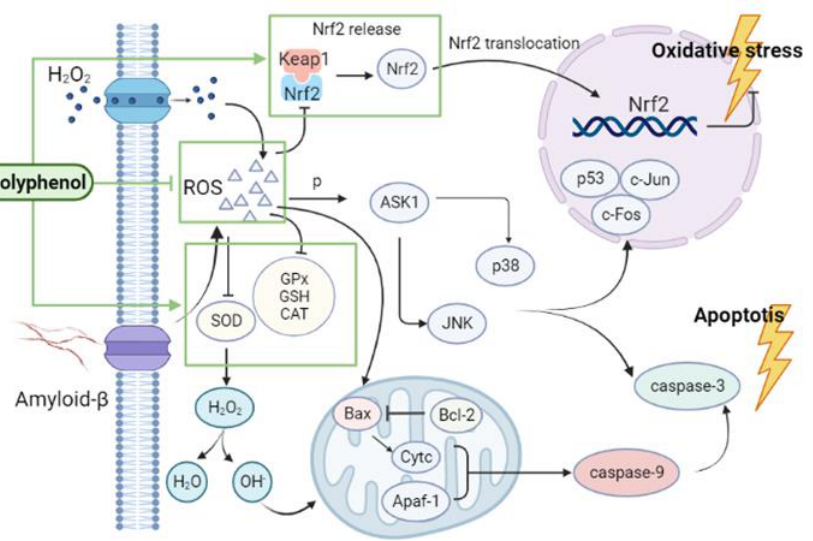
Figure 2. Regulatory roles of polyphenols in the context of oxidative stress: polyphenols can directly clear ROS and inhibit Keap1 to upregulate Nrf2 expression; increase SOD, CAT, and GSH activities; inhibit oxidative stress response; and thus alleviate AD symptoms. Nrf2, nuclear factor erythroid 2-related factor 2; Keap1, Kelch-like ECH-associated protein 1; p53, tumor protein P53; ROS, reactive oxygen species; ASK1, DASH complex subunit ASK1; SOD, superoxide dismutase; GPx, glutathione peroxidase; GSH, L-glutathione; CAT, catalase; Bax, apoptosis regulator BAX; Bcl-2, apoptosis regulator Bcl-2; Cytc, Cytochrome C; Apaf-1, apoptotic peptidase activating factor